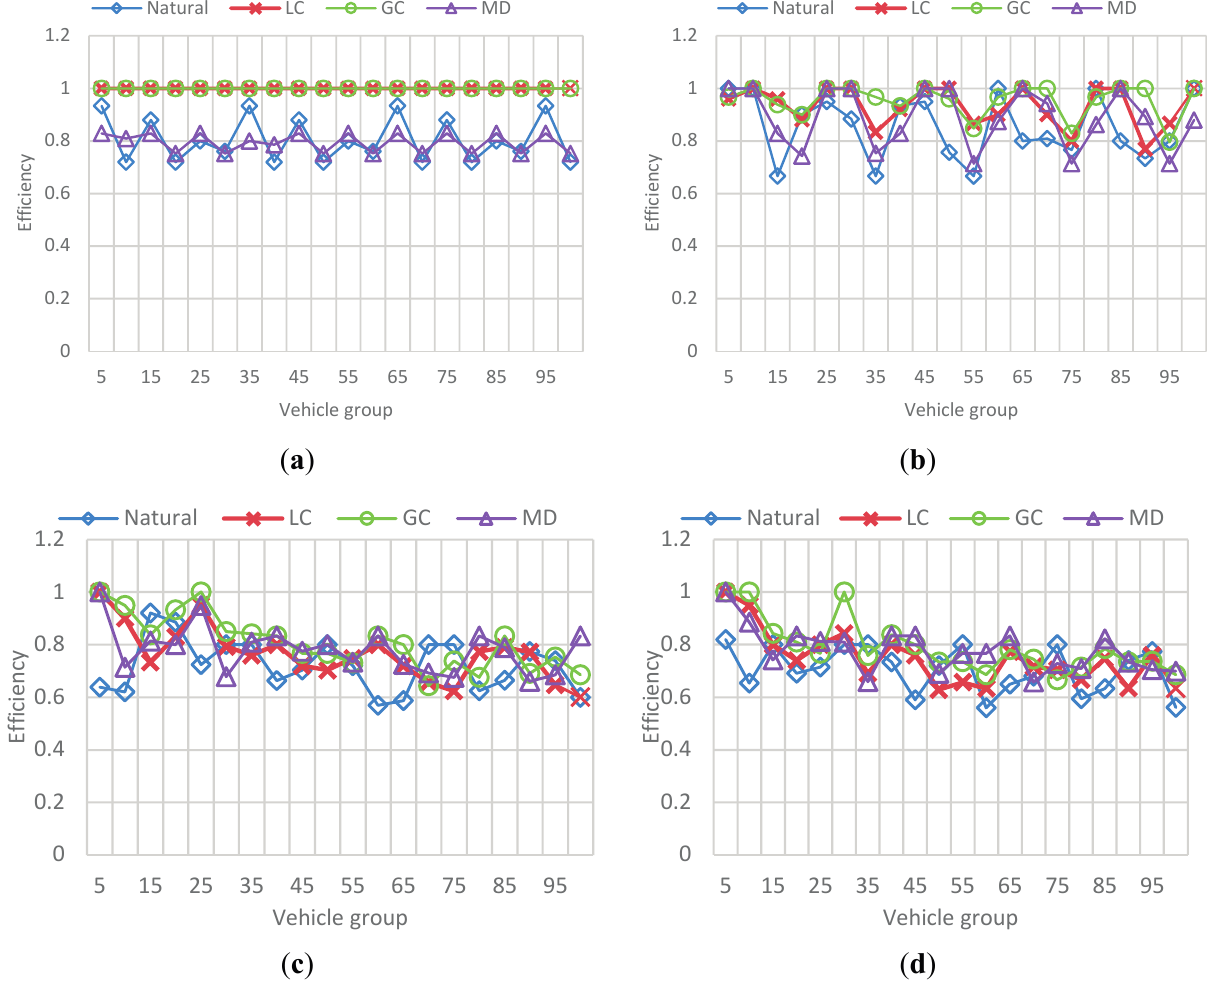
Figure 24. Behavior for route efficiency in the F-vehicles scenario. ( a ) Mean efficiency value for each 5-vehicles set when F is 10; ( b ) Mean efficiency value for each 5-vehicles set when F is 20; ( c ) Mean efficiency value for each 5-vehicles set when F is 30; ( d ) Mean efficiency value for each 5-vehicles set when F is